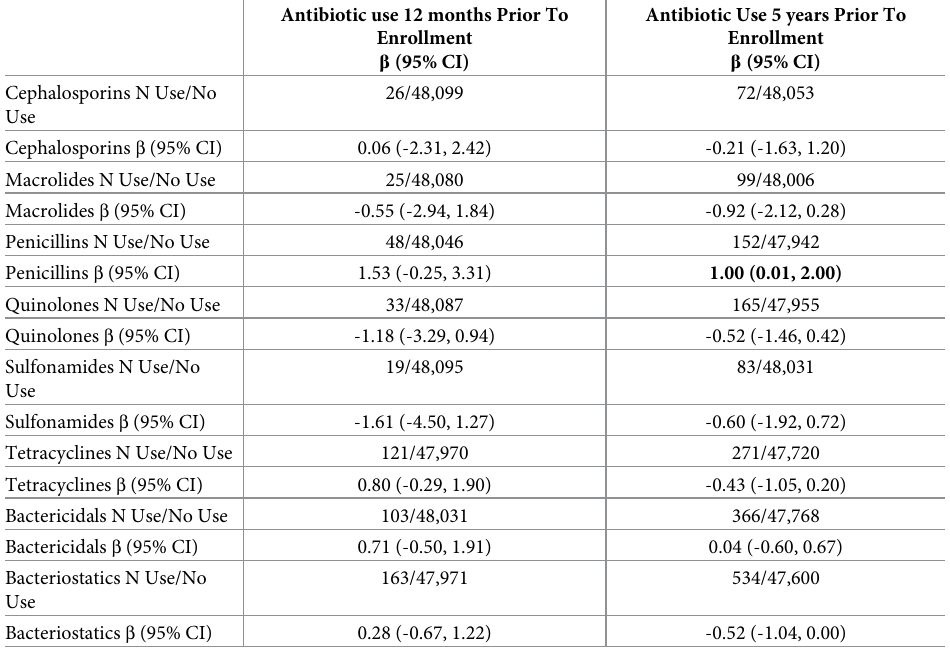
Table 5. Mixed models of longitudinal associations between antibiotic use before enrollment and percentage change in body mass index between follow-ups. Antibiotic use 12 months Prior To